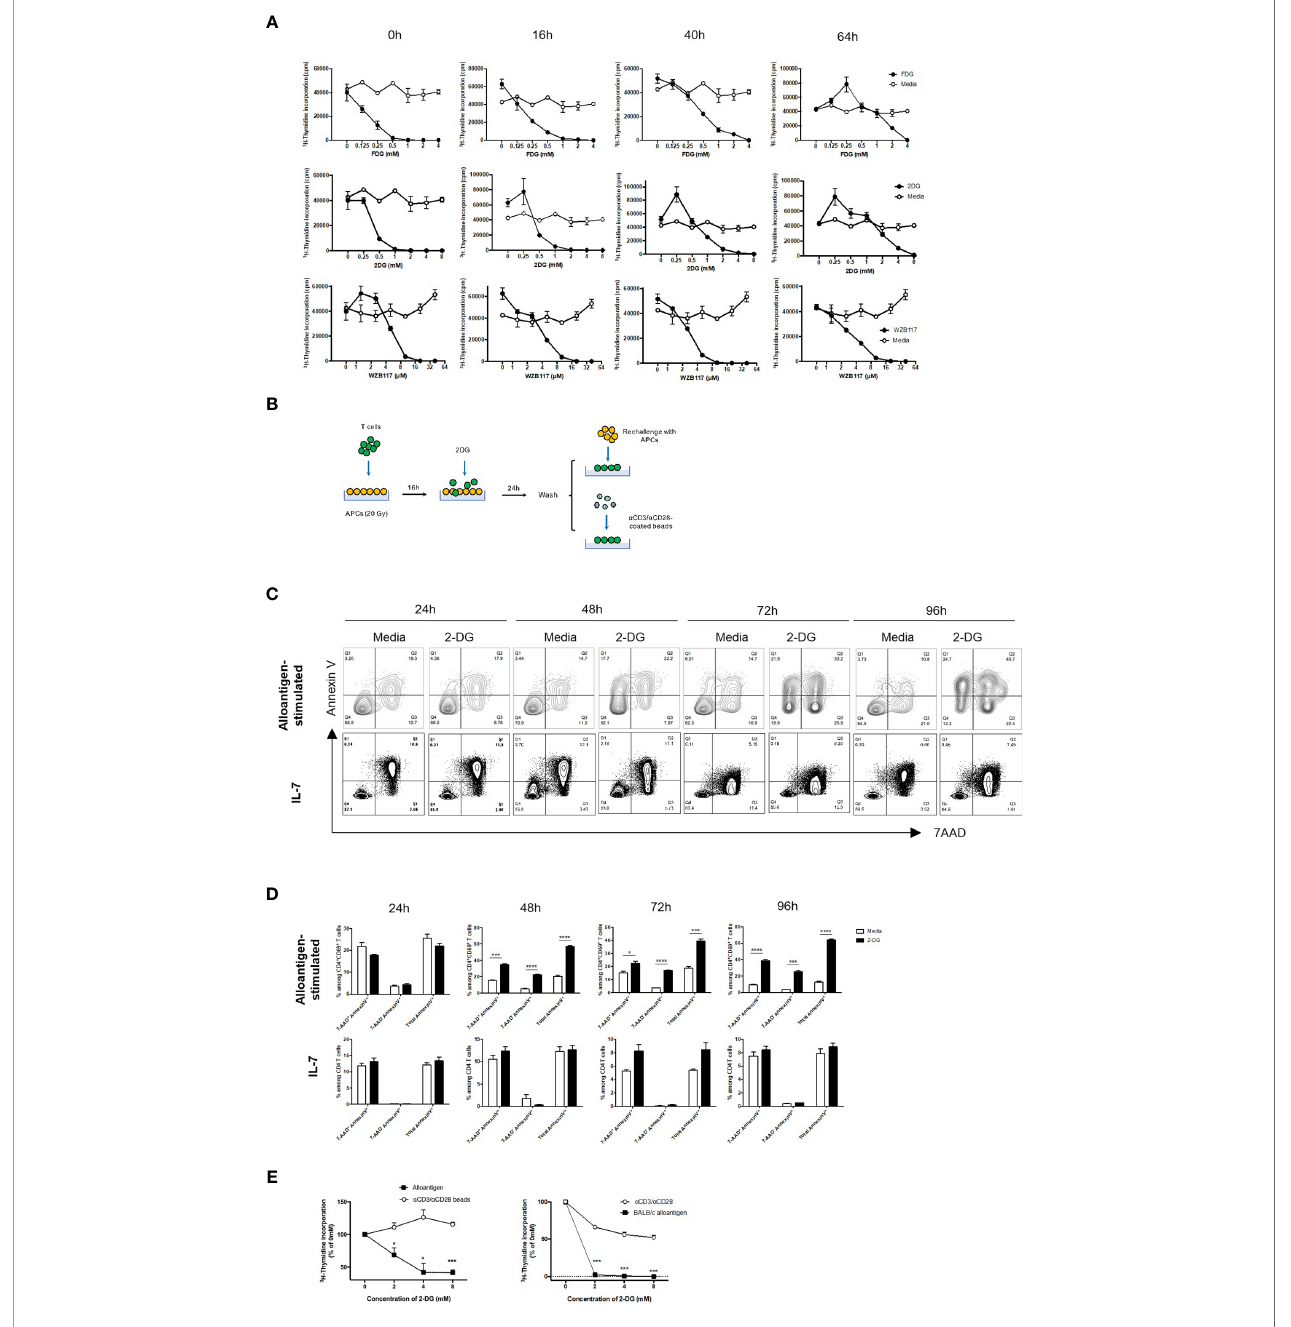
FIGURE 5 | 2-DG treatment selectively suppresses alloreactive T cells. WT or Glut1 T-KO T cells were stimulated for 0 hour, 16 hours, 40 hours, or 64 hours using irradiated (20 Gy) BALB/c splenocytes, followed by the addition of various concentrations of small molecule inhibitors and cultured for a total of 112 hours for the assessment of thymidine incorporation. T cell response was determined following the addition of FDG or media only (H 2 O), 2-DG or media only (H 2 O), WZB117 or media only (EtOH) (A) . Schematic diagram of T cells stimulated with irradiated MHC-mismatched APCs for 16 hours, followed by the addition of various concentrations of 2-DG, washed, then rechallenged with alloantigens or anti-CD3 and anti-CD28 antibodies (B) . WT T cells were fi rst stimulated with irradiated (20 Gy) BALB/c DCs for 16 hours, followed by incubation with freshly isolated irradiated DCs in the presence of media control or 8mM 2-DG for 24-96 hours; WT T cells were cultured in IL-7 (10ng/ml) for 16 hours plus 24-96 hours, and analyzed for Annexin V and 7AAD (C, D) . T cells were gated on CD4 + CD69 + for alloantigen-stimulated samples and CD4 + for IL-7-treated samples. (E) The proliferative response of mouse (left panel) and human T cells (right panel) cultured according to (B) was measured by 3 H-TdR incorporation assay. *P < 0.05, ***P < 0.001, ****P < 0.0001, 2-tailed Student t test; data are representative of two experiments (n = 3 per